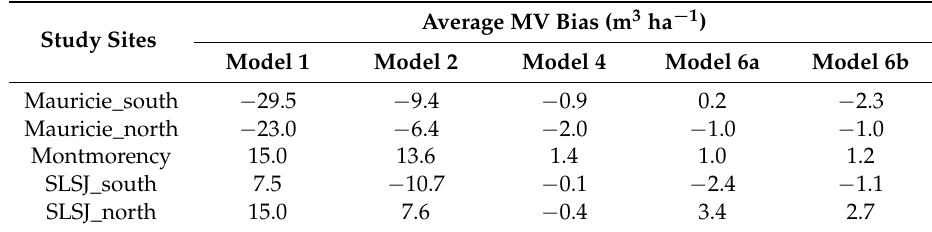
Table 4. Average biases of the merchantable volume (MV) models per study